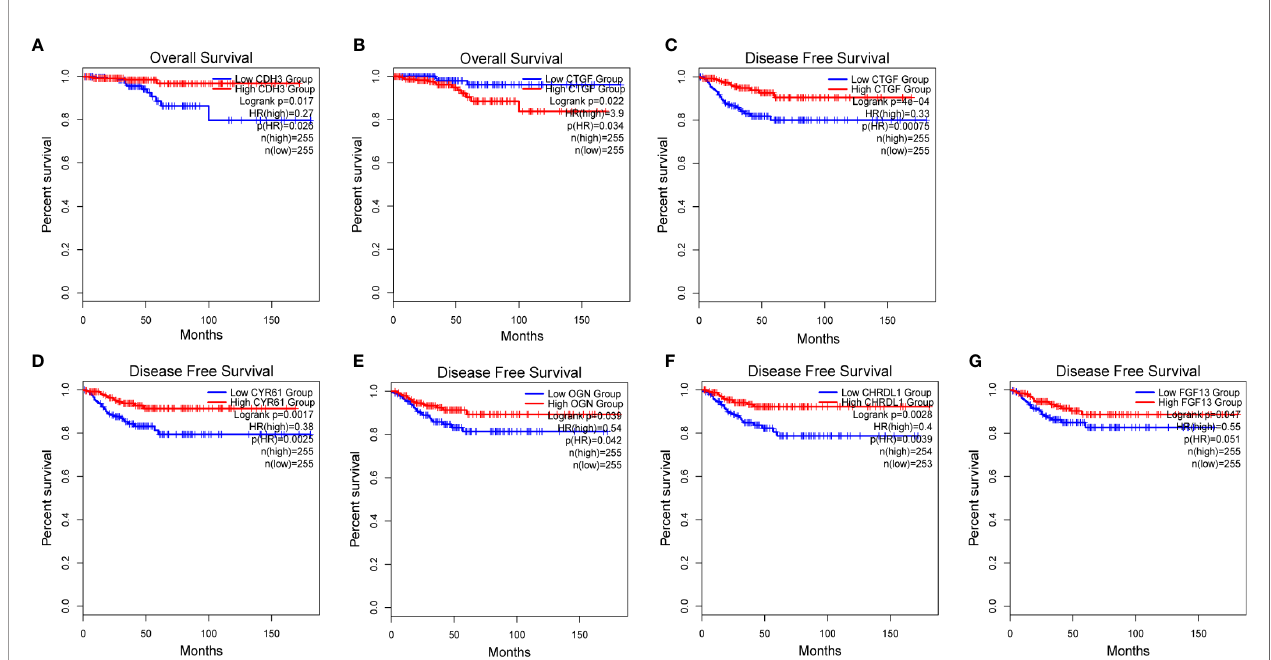
FIGURE 8 | Survival analysis of 6 hub genes. (A, B) Kaplan-Meier survival analyses of TCGA PTC patients based on the expression of CDH3 and CTGF . (C – G) Disease-free survival (DFS) of TCGA PTC patients based on CTGF, CYR61, OGN , CHRDL1 and FGF13 ,